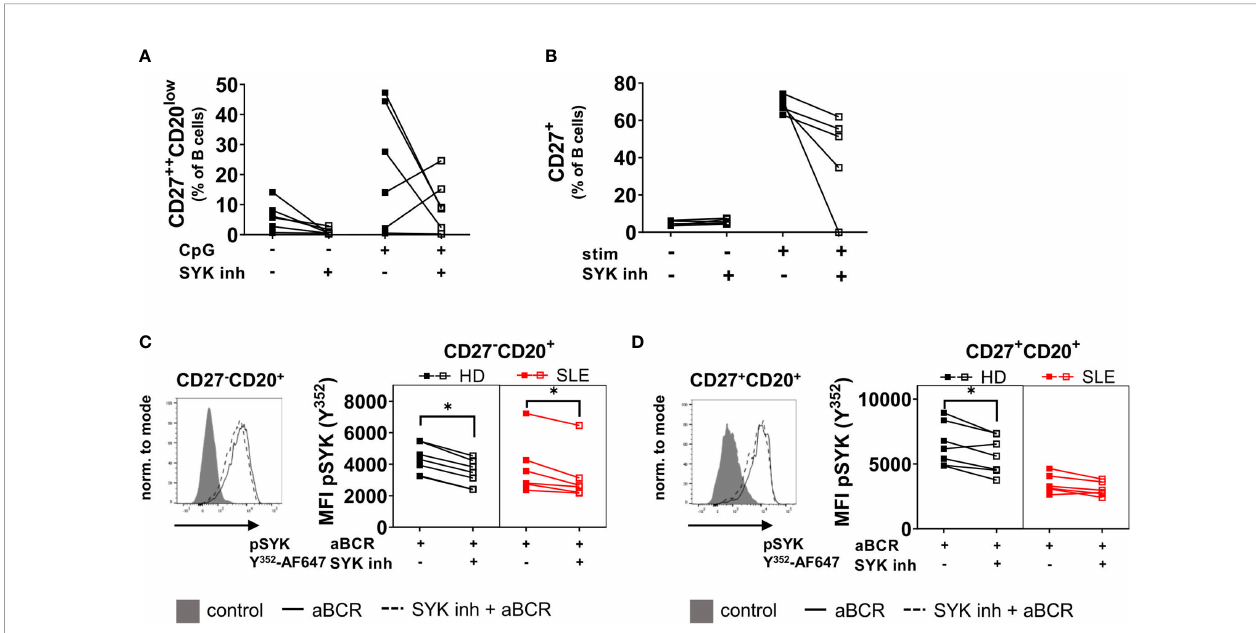
FIGURE 3 | Inhibition of SYK results in reduced differentiation and activation of PBMC from HD and reduced phosphorylation of pSYK in pre-switch CD27-CD20+ B cells from HD and SLE patients. (A) HD PBMCs were stimulated with CpG for fi ve days together with the SYK inhibitor entospletinib or DMSO as a control. Resulting frequencies of CD27 ++ CD20 low plasmablasts among CD19 + CD20 +/- B cells and cumulative data. HD n=6. (B) Sorted CD27 - IgD + naïve HD B cells were stimulated with a combination of IL-2, IL-10, CpG, aBCR and CD40L for fi ve days at 37°C and 5% CO 2 with or without the SYK inhibitor entospletinib. Cumulative data of the frequency of CD27 + cells among CD19 + CD20 +/- B cells. HD n=5. (C, D) SLE and HD PBMCs were stimulated for 5 min with aBCR and stained for pSYK Y 352 in combination with markers to identify CD27 - CD20 + (C) and CD27 + CD20 + (D) B cell subsets. A representative histogram and the MFI of pSYK Y 352 is shown. HD n=7, SLE n=6. Wilcoxon signed rank test. *p <